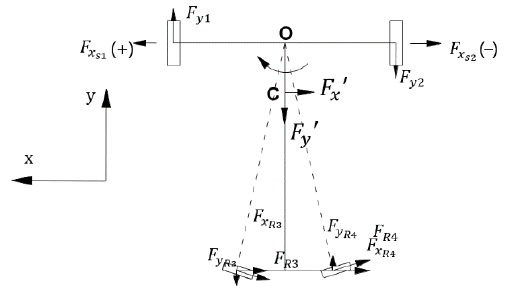
Figure 4. Force analysis of AGV.